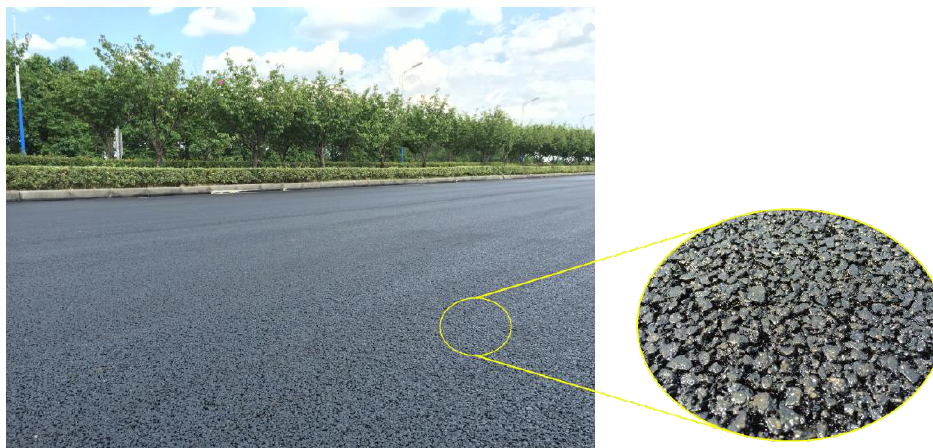
Figure 16. Paving completed.